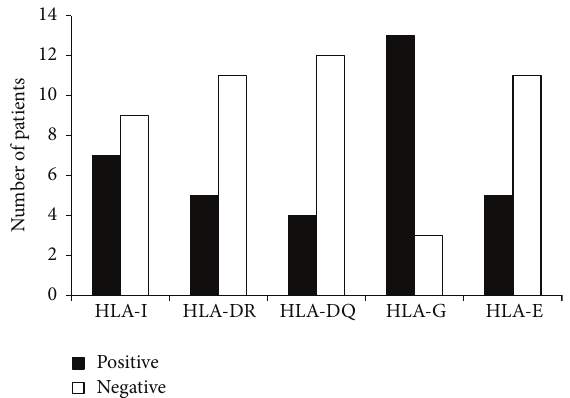
Figure 4: Immunohistochemical expression of HLA class Ia (-A, -B, and -C), HLA class II (DR and DQ), and HLA class Ib (HLA- G and HLA-E), in the tumor cells observed in the 16 lymph nodes of patients with metastases in axillary lymph nodes. Exact Fisher Test, 𝑃 = 0.0091 , 𝑃 < 0.05